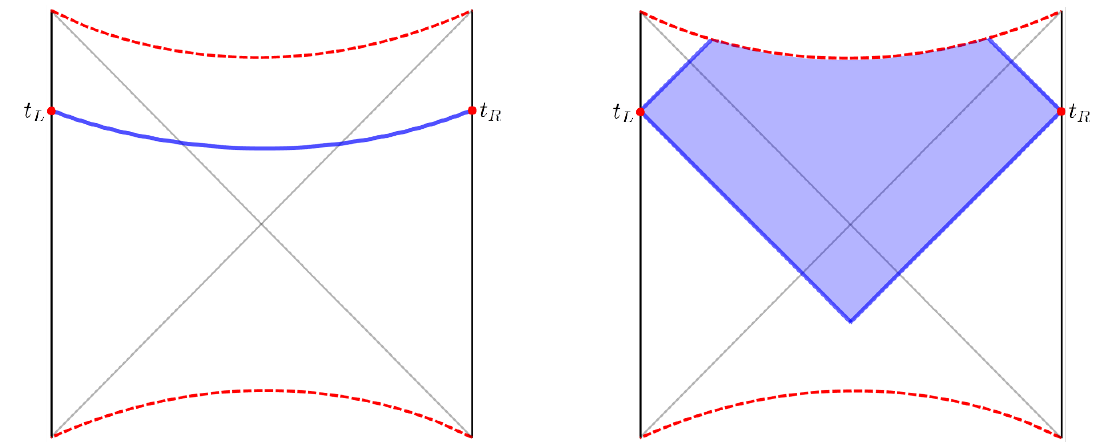
Figure 1 . Complexity=volume (CV, left) and complexity=action (CA, right) for the eternal AdS black hole dual to the thermo(cid:12)eld double state (1.1). In the left panel, the blue curve represents the maximal spacelike surfaces that connects the speci(cid:12)ed time slices on the left and right boundaries. In the right image, the shaded region is the corresponding WDW